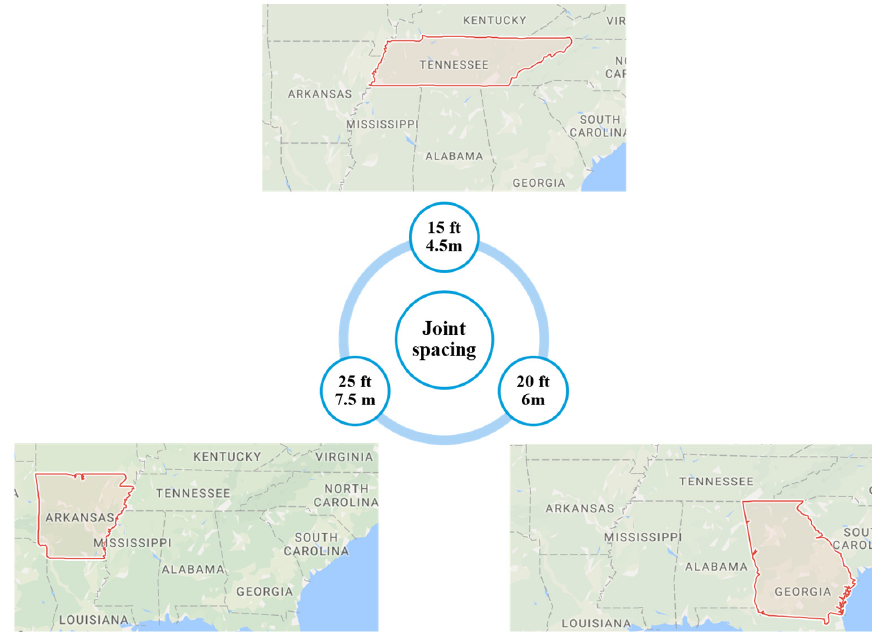
Figure 1. Locations of three extracted sections in terms of the LTPP database. Table 1. The locations and joint spacings of selected